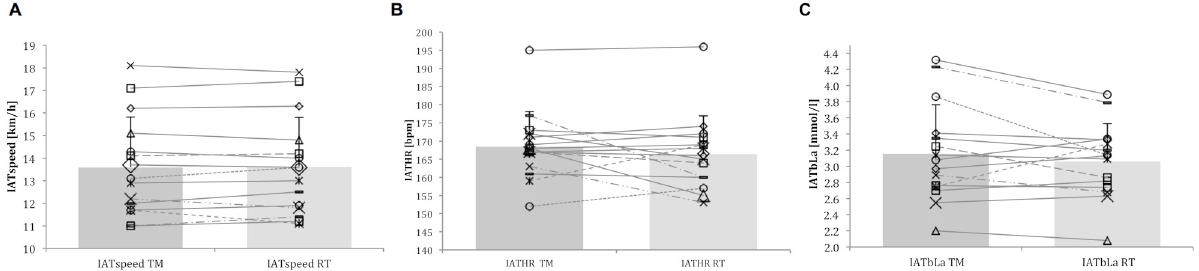
Fig 1. Individual and overall mean performance in TM and RT including standard deviation. (A) IAT speed , (B) IAT HR and (C) IAT bLa .